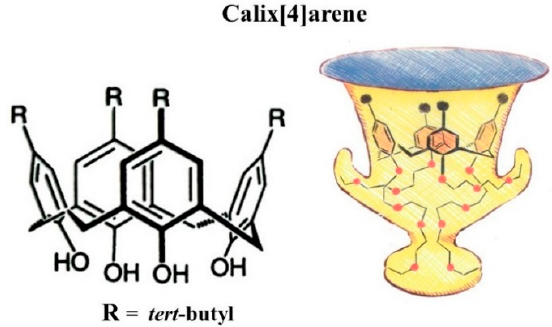
Figure 29. The structure of calix[4]arene. Reproduced with permission of the Royal Society of Chemistry from [114].